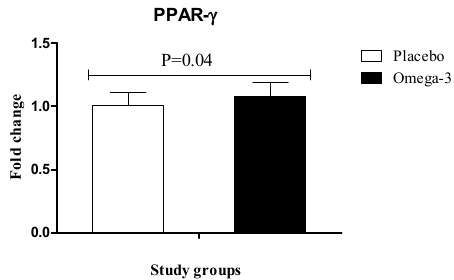
Figure 2. Effect of 6-week supplementation with omega-3 or placebo on expression ratio of PPAR- γ gene in PBMCs of GDM women.